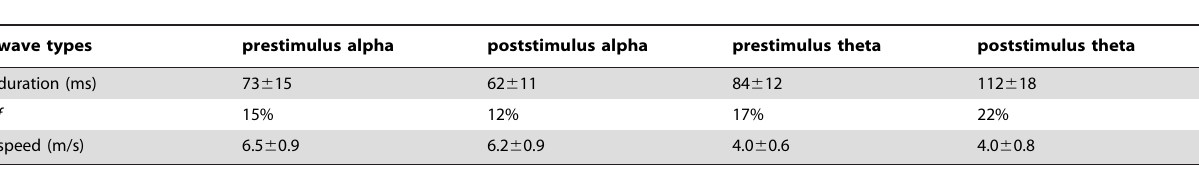
Table 1. Average durations and speeds of pre- and post stimulus alpha and theta oscillations.